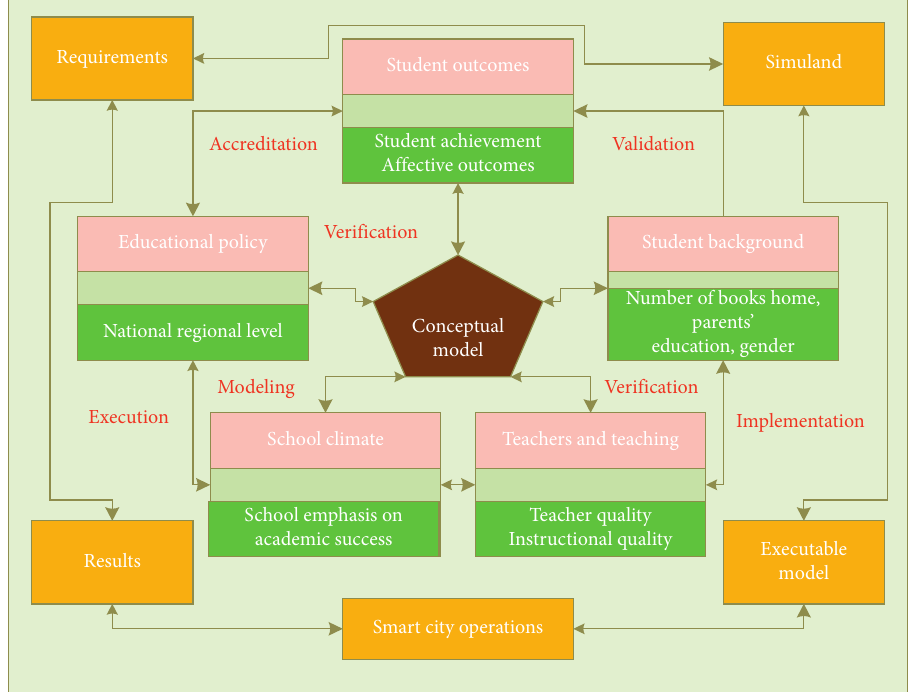
Figure 1: The conceptual composition model of the influencing factors of case teaching